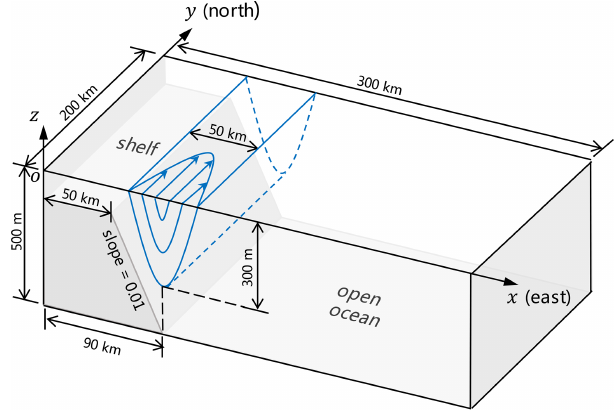
Figure 2. Schematic of the model domain and bottom topography. The initial current flows northward along the channel with its on- shore part overlying the continental